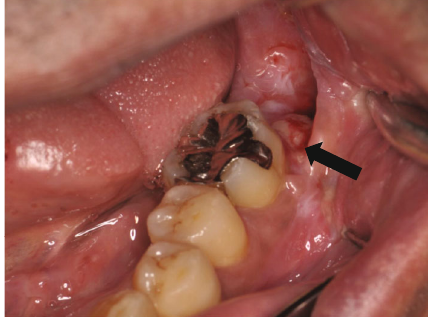
Figure 4: The excised site after one week. A stump of the mass can be seen on the mesial wall of the extraction socket (arrow).